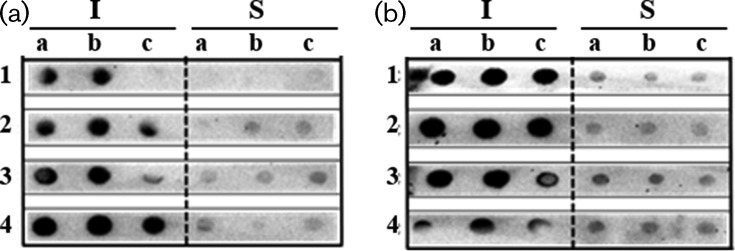
Dot-blot analysis of both the soluble (S) and insoluble (I) fractions resulting from the expression of fusions His6MBPBladSP10-5 (a) and His6MBPBladSub5 (b) at four different temperatures (1–20 °C; 2–25 °C; 3–30 °C and 4–37 °C) with three IPTG concentrations (a – 1 mM, b – 0.5 mM and c – 0.1 mM).